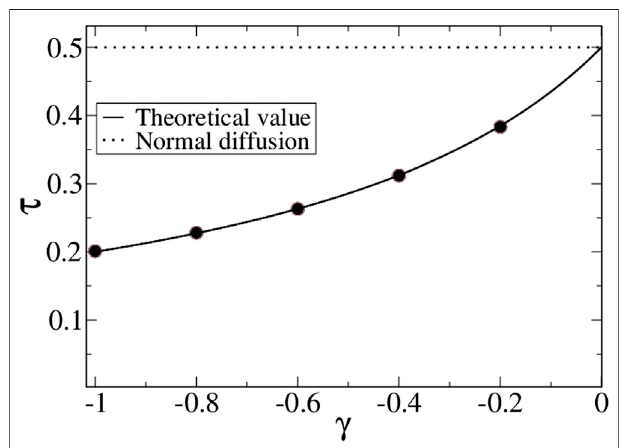
FIGURE7| Simulation results for τ using the fi niterange ( Δ x (cid:1) 1 ) model for c ≤ 0 values (black symbols). The full line is the theoretical